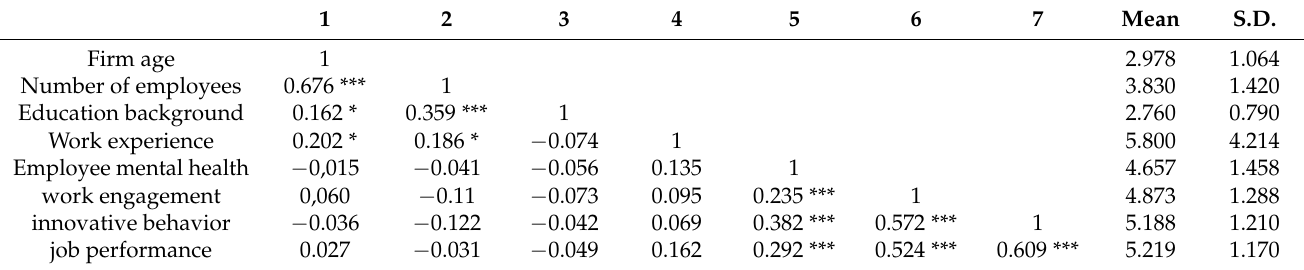
Table 1. The results of the correlation matrix and descriptive statistics.